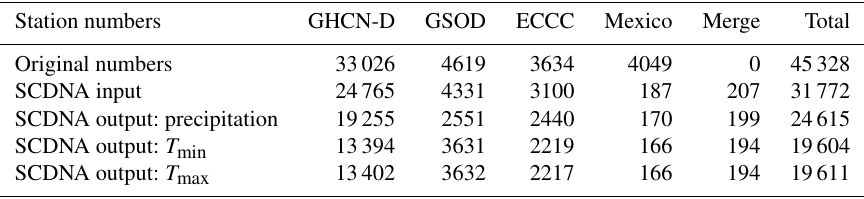
Table 1. Numbers of stations with at least 8-year-long records from 1979 to 2018.